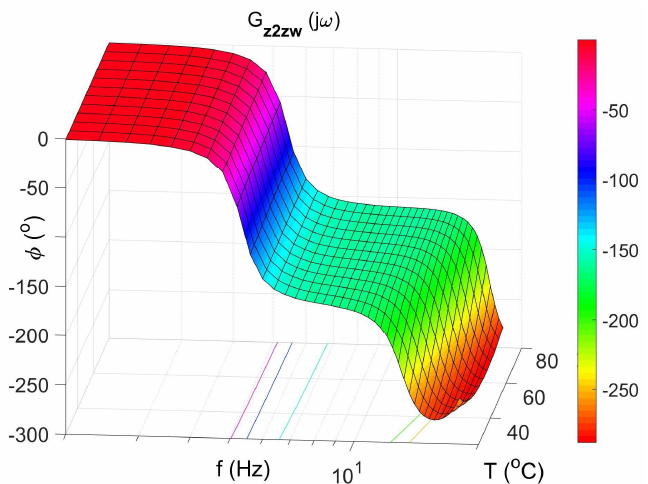
Figure 13. Protect mass phase shift between displacements z w and z 2 as a function of frequency and temperature, the transfer function G z 2 zw